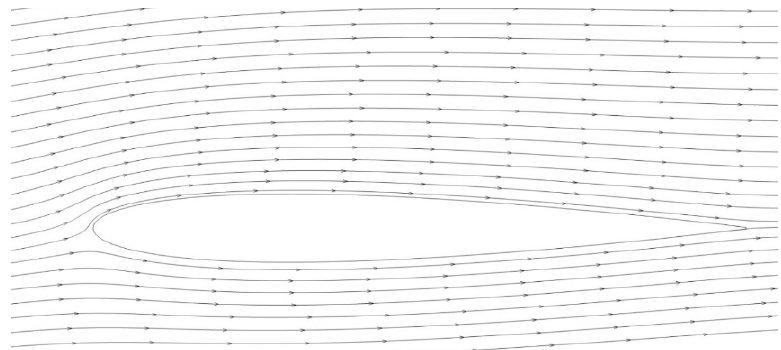
Figure 18. 4° angle of attack, streamline of grooves on the suction side.